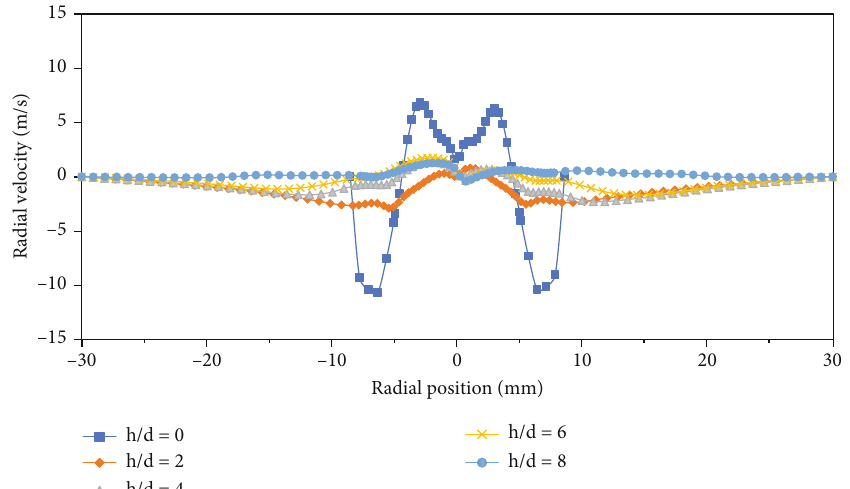
Figure 11: Development of radial velocity of water.